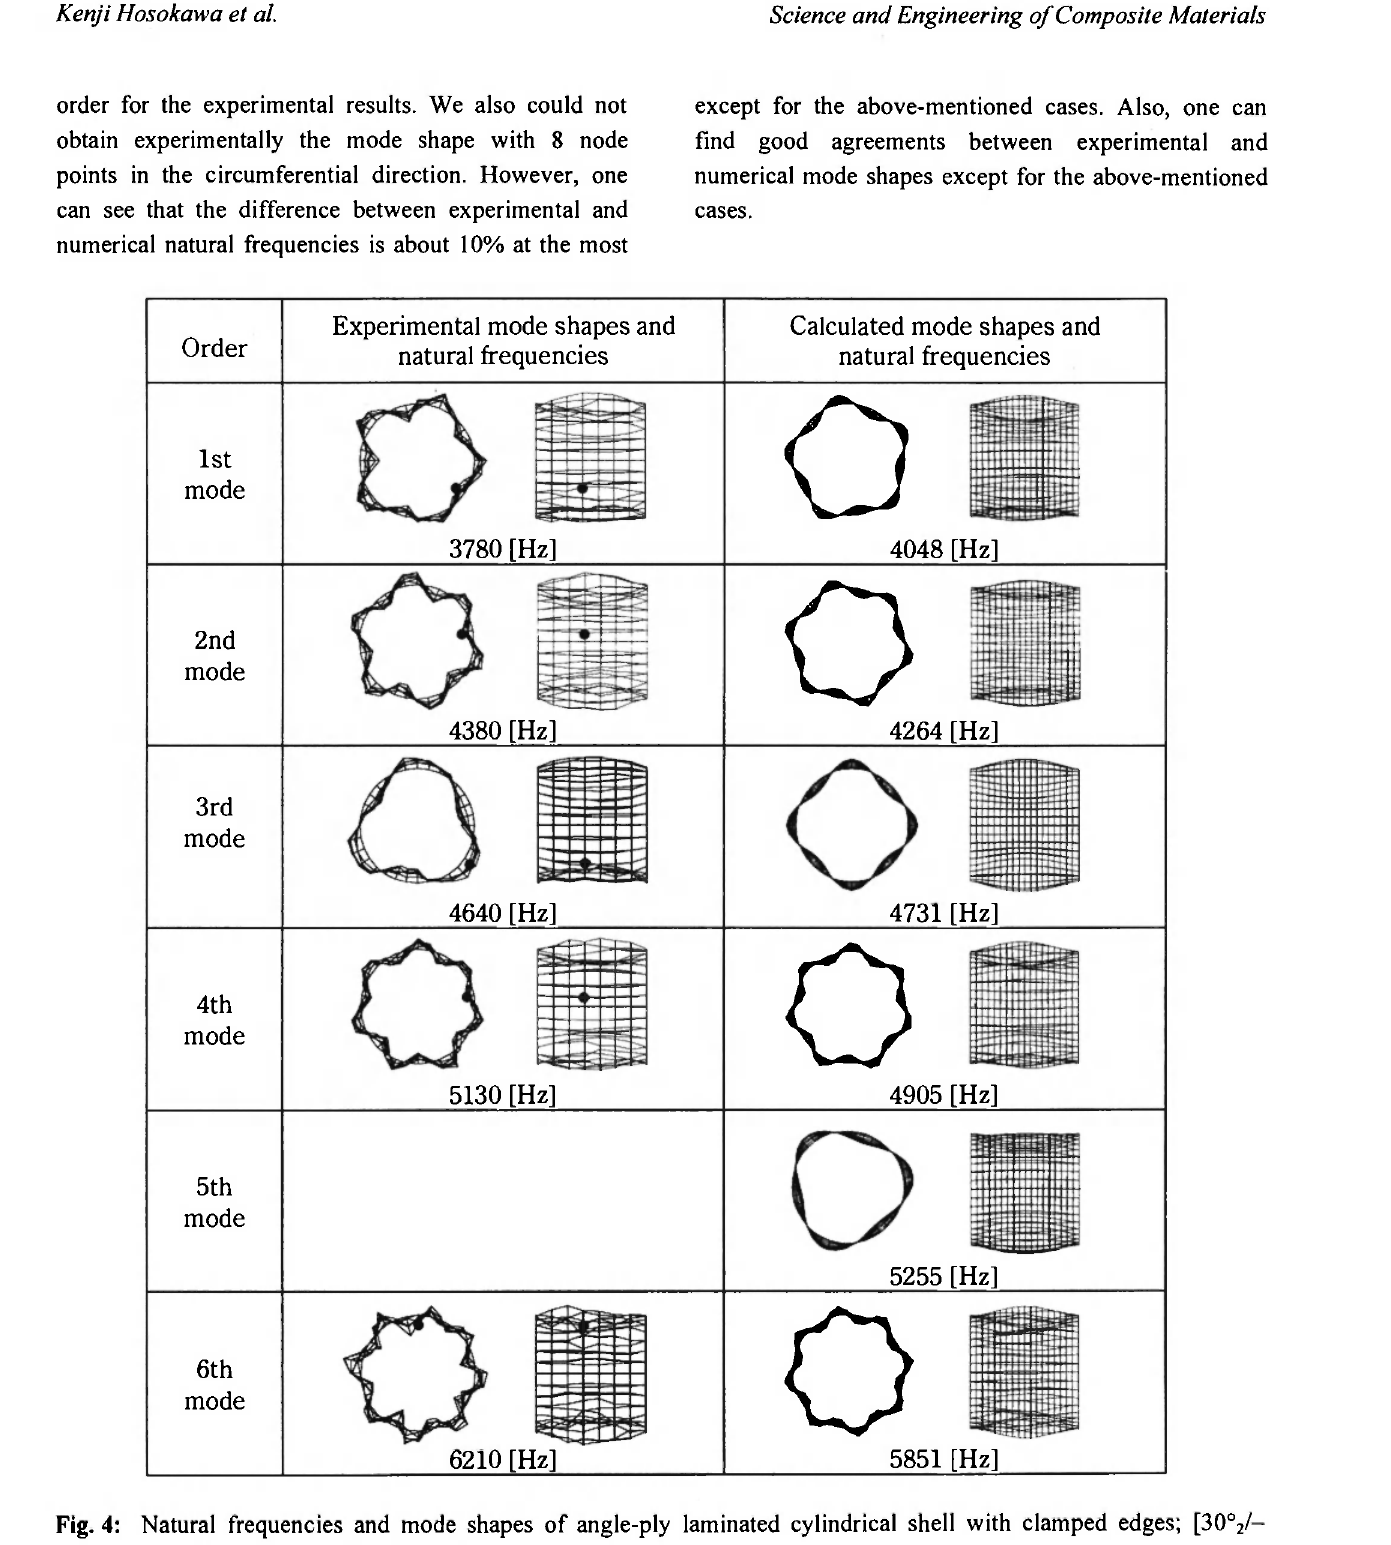
Fig. 4: Natural frequencies and mode shapes of angle-ply laminated cylindrical shell with clamped edges; [30° 2 /- 30° 2 /-30 o 2 /30° 2 ], CFRP (/= 98